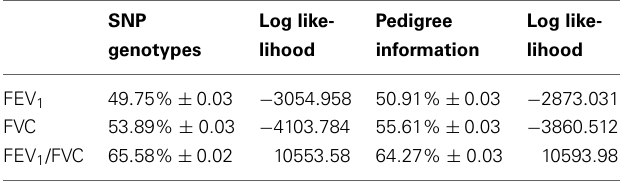
Table 2 | Heritability estimates and log-likelihood of models for pulmonary phenotypes based on SNP genotypes and on pedigree information ( ± standard error).